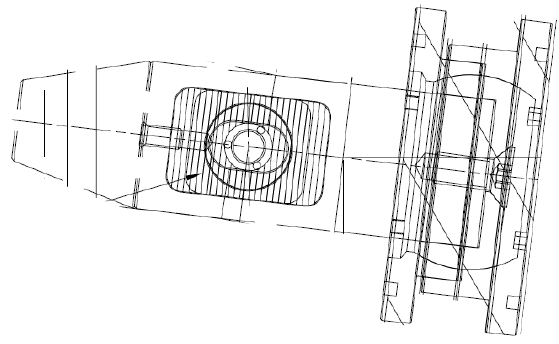
Figure 2: Rotule at North Wall